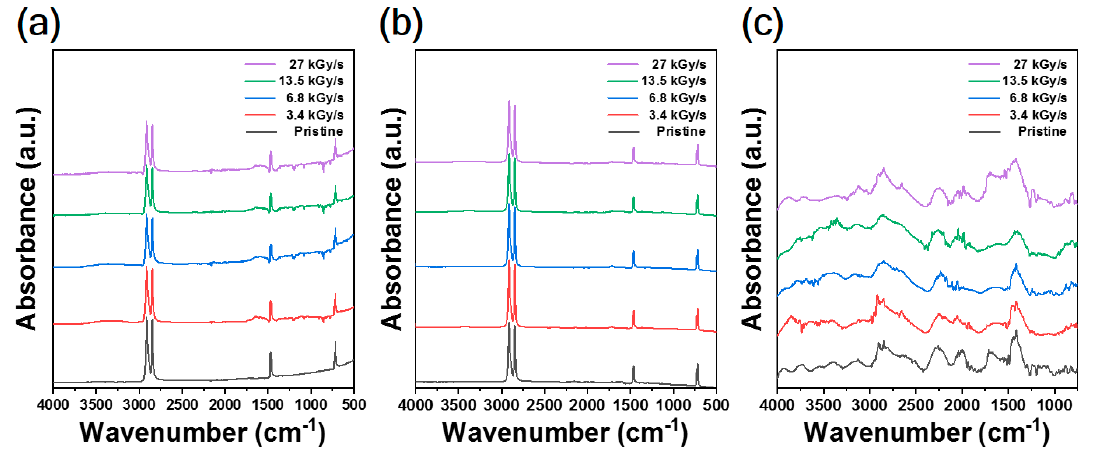
Figure 2. FT-IR spectra of ( a ) CFRTP, ( b ) HDPE, and ( c ) CF irradiated at various absorbed dose rates.